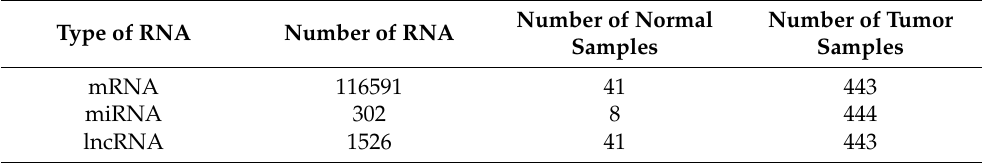
Table 3. Edge Information in Heterogeneous